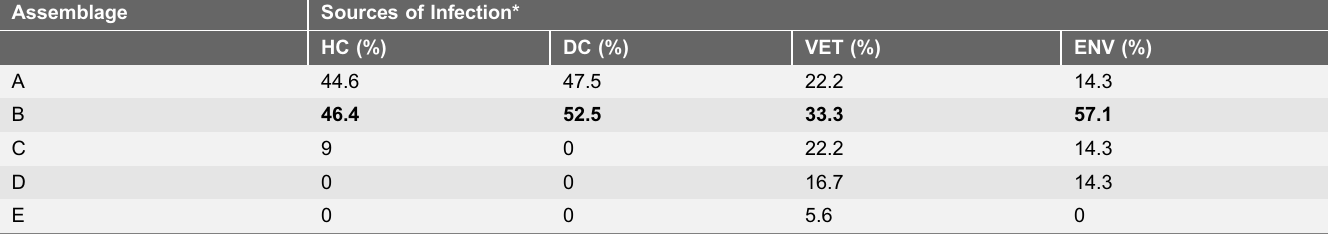
Each source of samples was examined to identify the genetic assemblages that contributed most to the isolates. The relative distribution considers all of the genes and includes the results of mixed assemblages. Bold numbers indicate the highest percentage per column. * Hospital group (HC), day-care center group (DC), veterinary group (VET) and environmental group